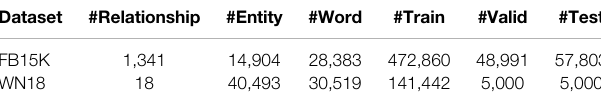
TABLE 2 | Parameter settings. Parameter